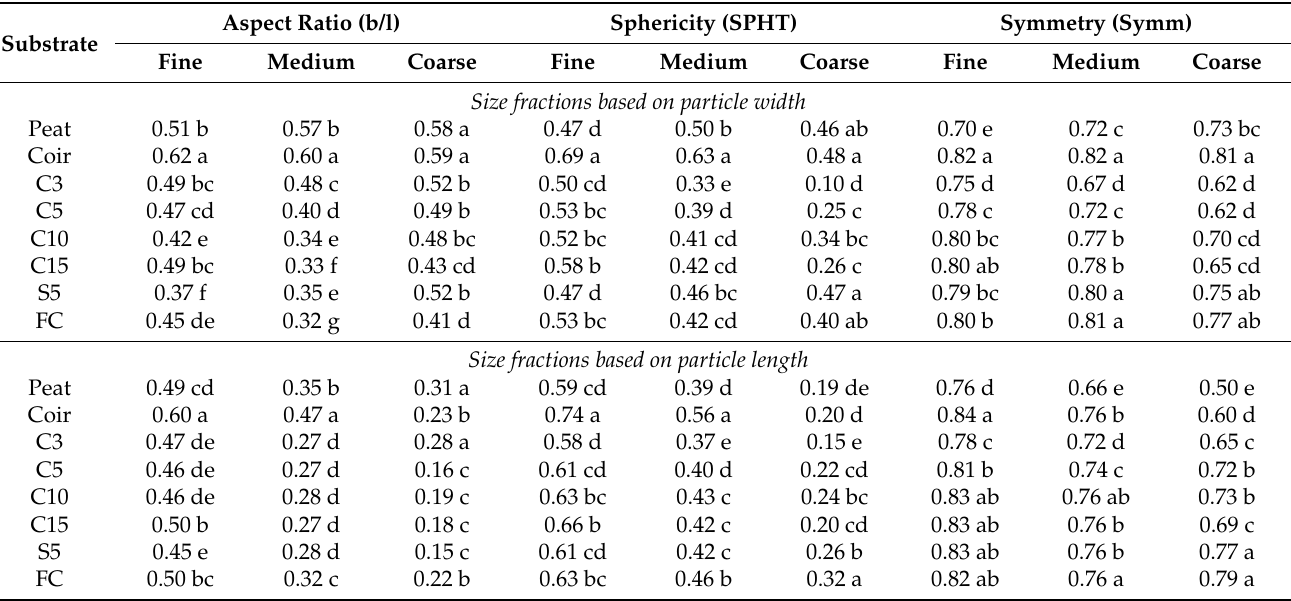
Table 5. Volume-based particle shape parameters of peat, coir and processed miscanthus substrates using dynamic image